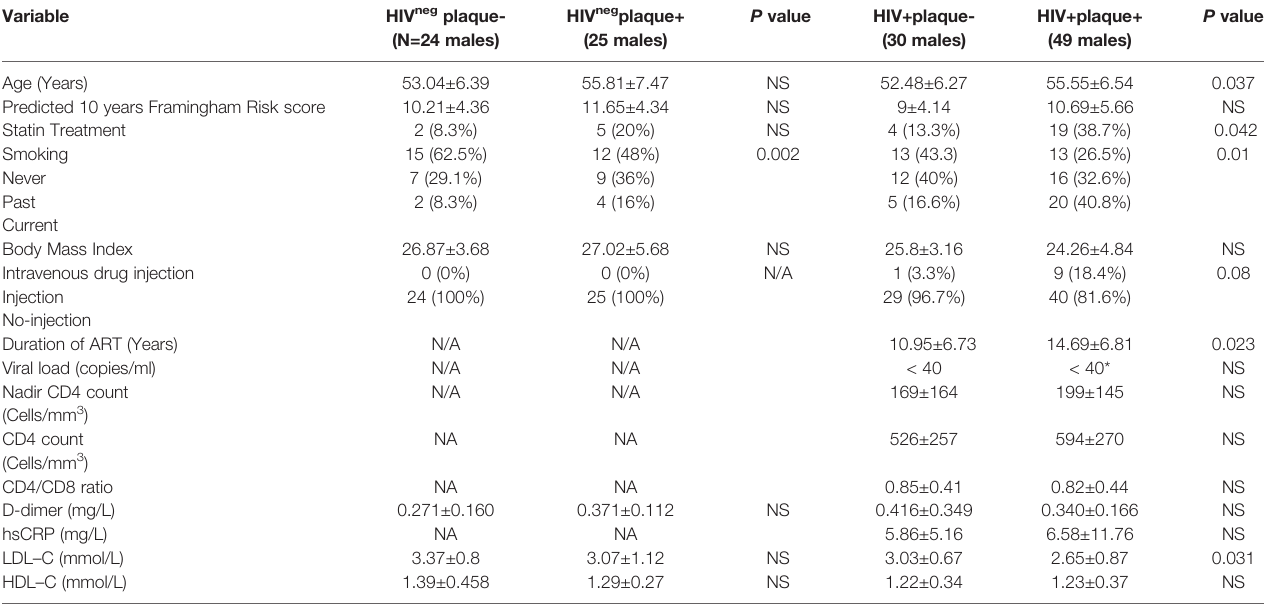
TABLE 1 | Demographic and clinical parameters of study